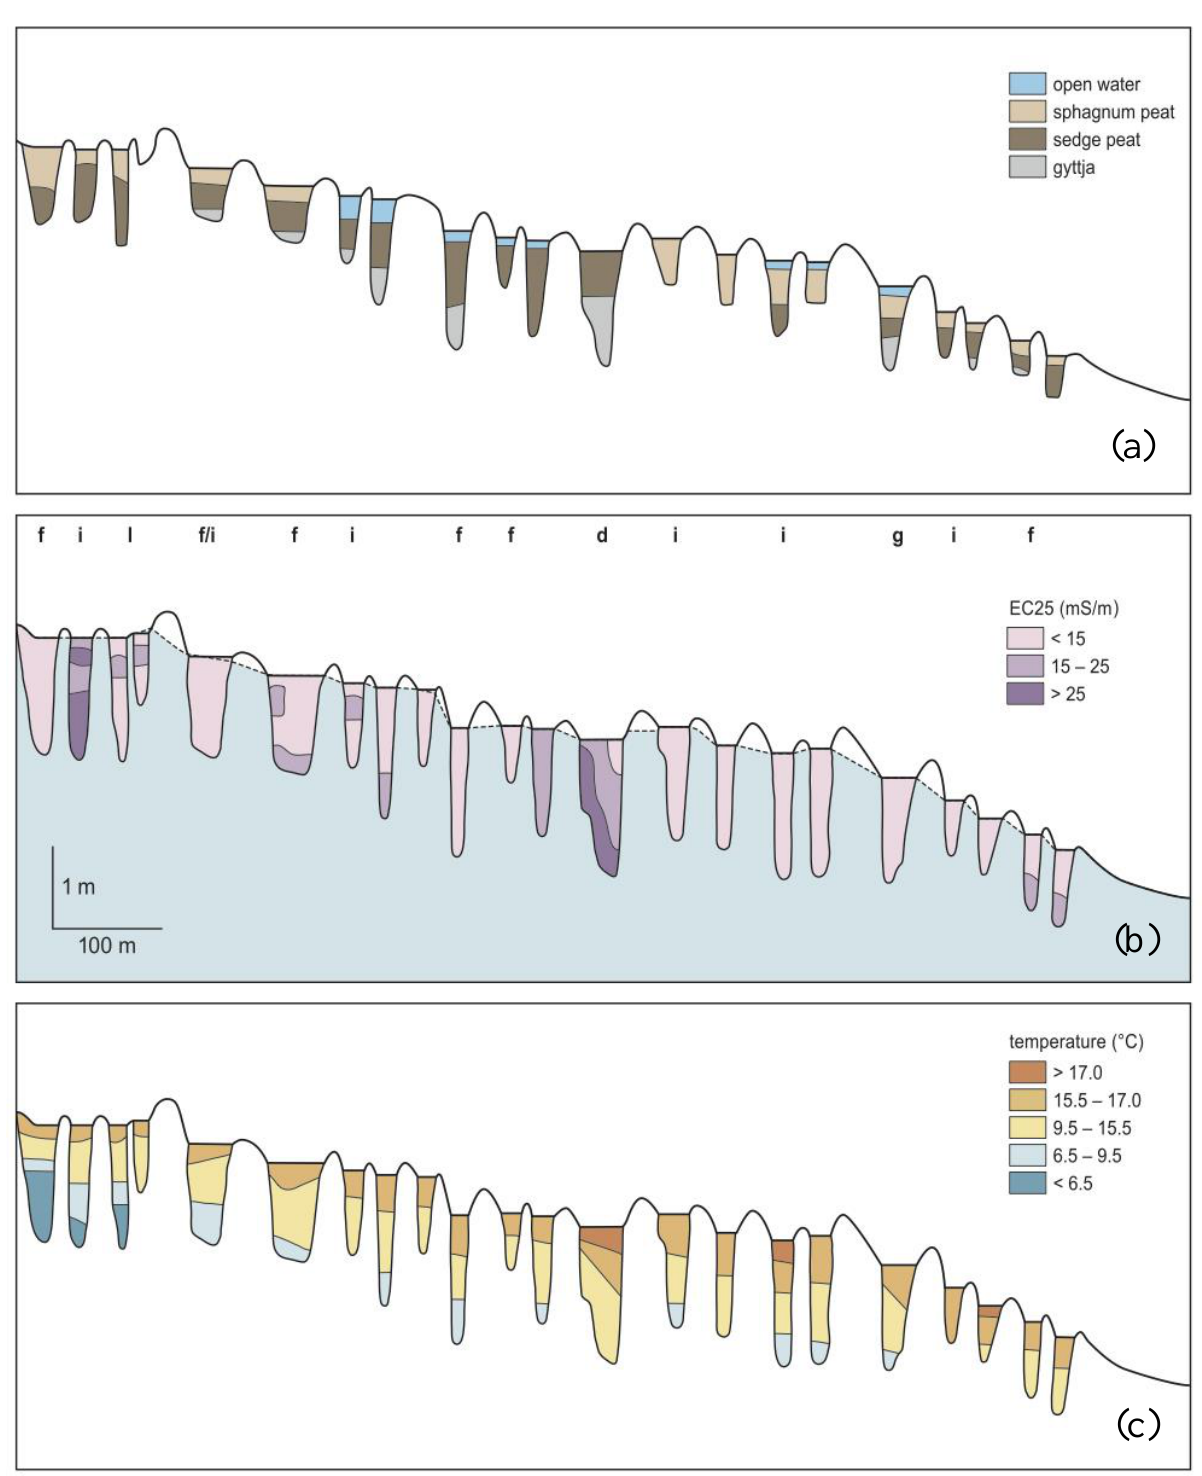
Figure 5. Showing a) peat profiles along the transect (codes at the uppermost line ( c-i ) relate to the vegetation types distinguished in the present study (Appendix), b) results of electrical conductivity measurements in all peat profiles along the transect measured in July 2009 and c) results of temperature measurements measured in July